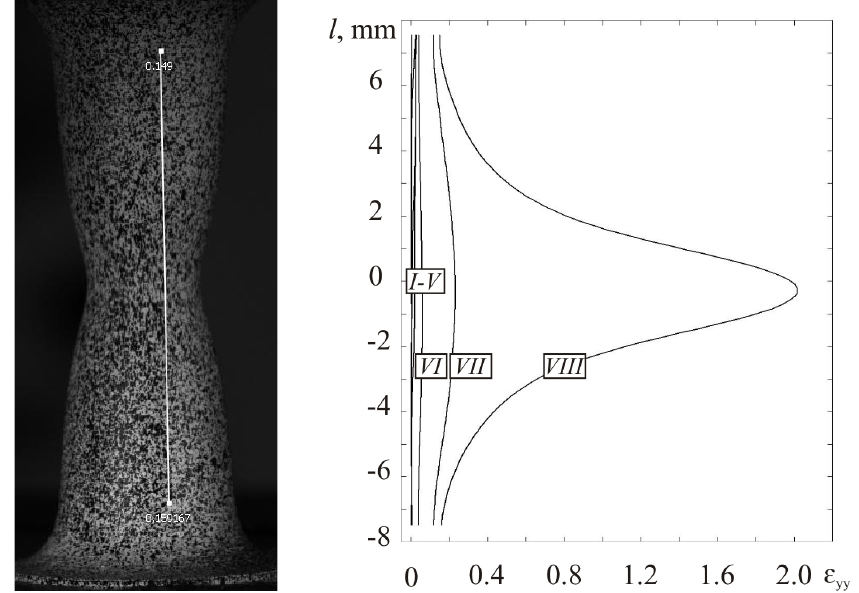
Figure 4: Axial strain distributions on surface of cylindrical sample.